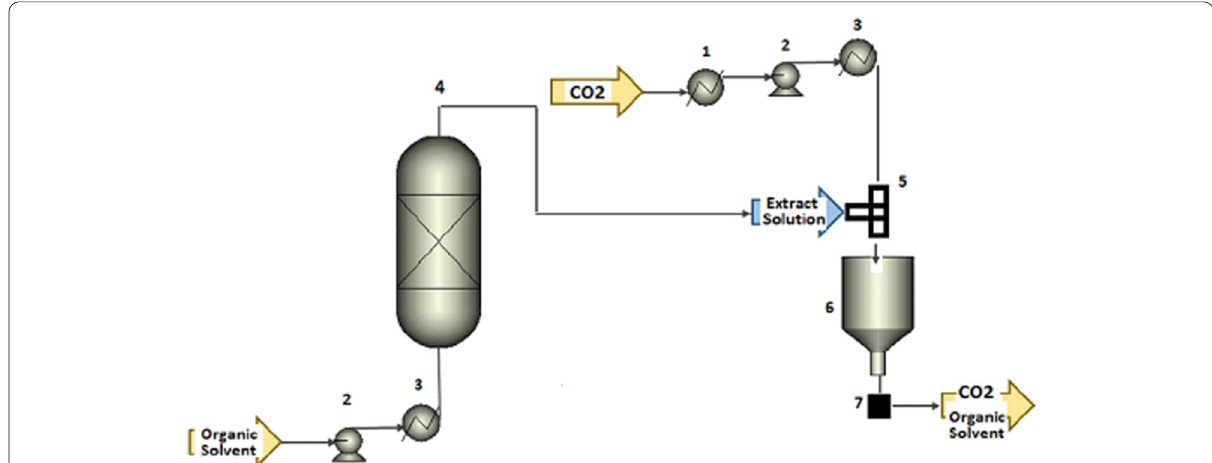
Fig. 5 PLE process using organic solvent as extracting solvent coupled with supercritical antisolvent (SAS) precipitation process (1) heat exchanger for cooling, (2) pump, (3) heat exchanger for heating, (4) extractor, (5) T-mixer, (6) precipitation vessels, and (7) filter (Santos and Meireles